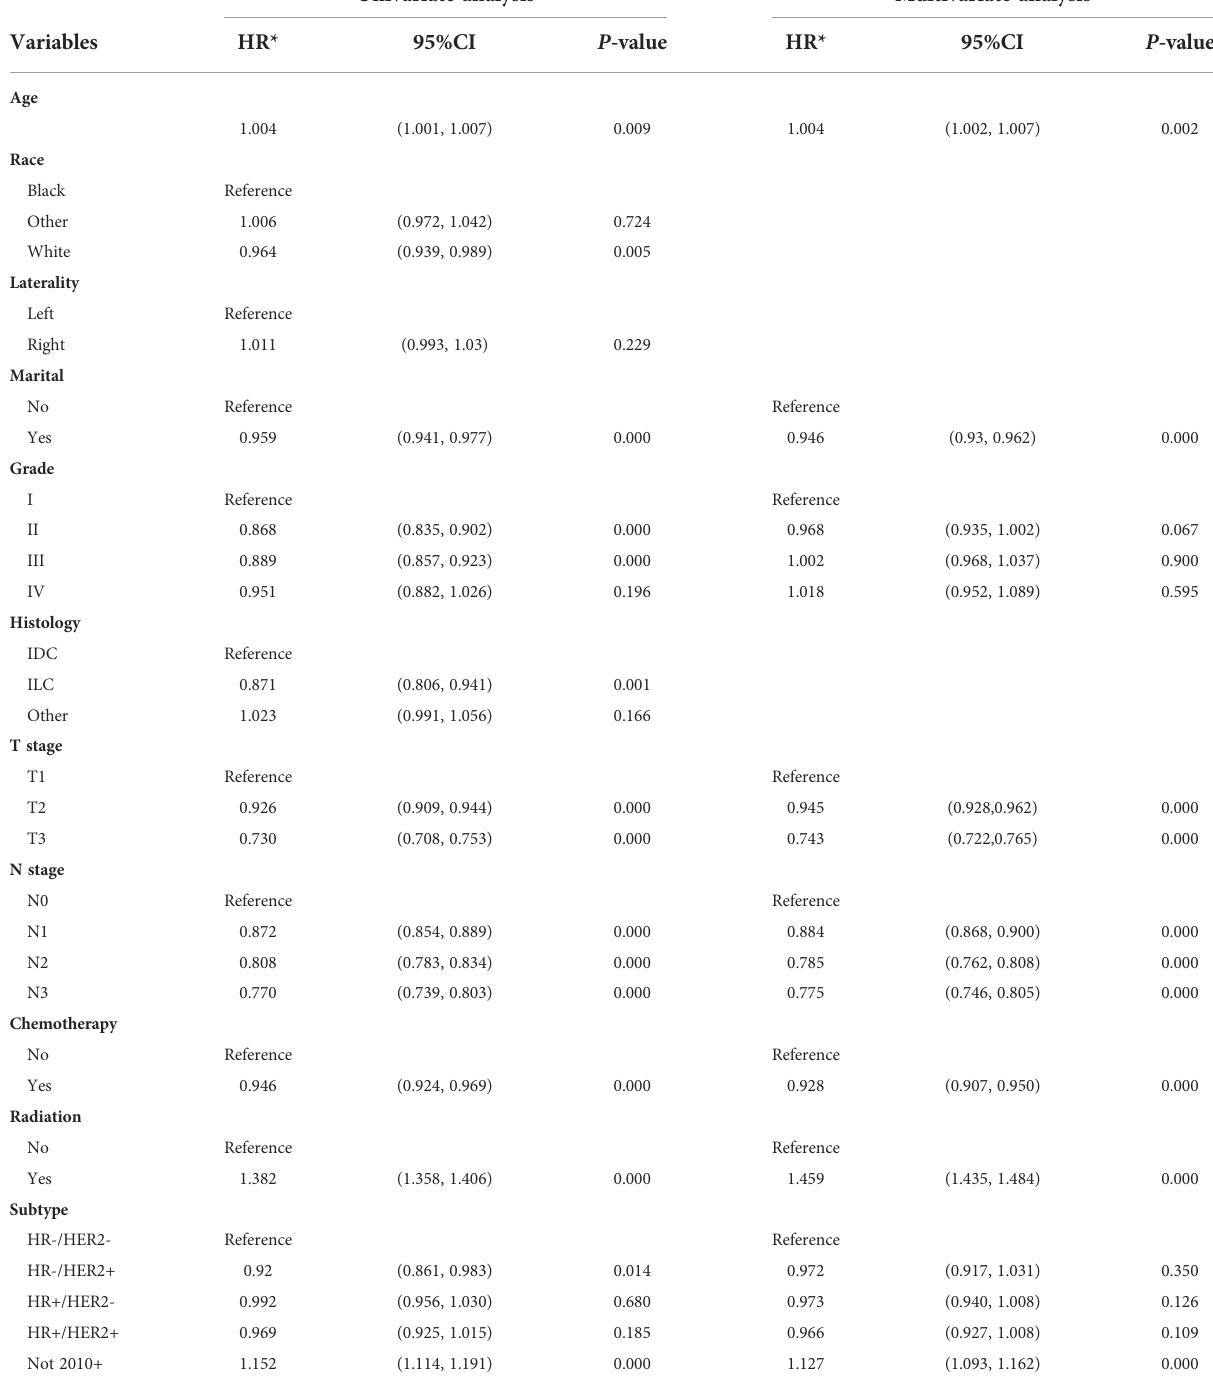
TABLE 4 Univariate and multivariable Logistic analysis of BCS bene fi t for young breast cancer patients. Univariate analysis Multivariate